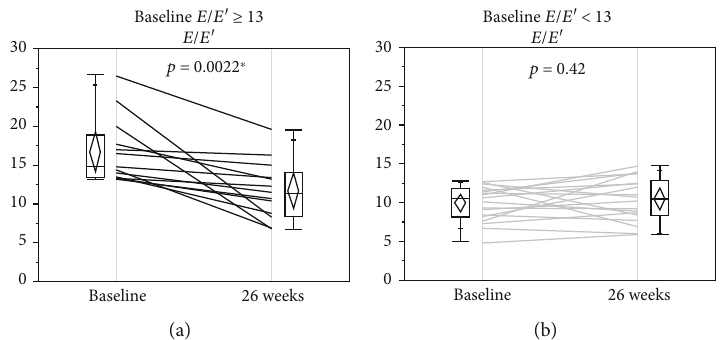
Figure 2: Comparison of E / E ′ at baseline and 26 weeks after liraglutide introduction in patients with E / E ′ ≥ 13 ( N = 13 ) and those with E / E ′ < 13 ( N = 18 ). Changes in E / E ′ (a) in patients with E / E ′ ≥ 13 and (b) in patients with E / E ′ < 13 . E / E ′ : E wave to E ′ ratio on tissue Doppler echocardiography.